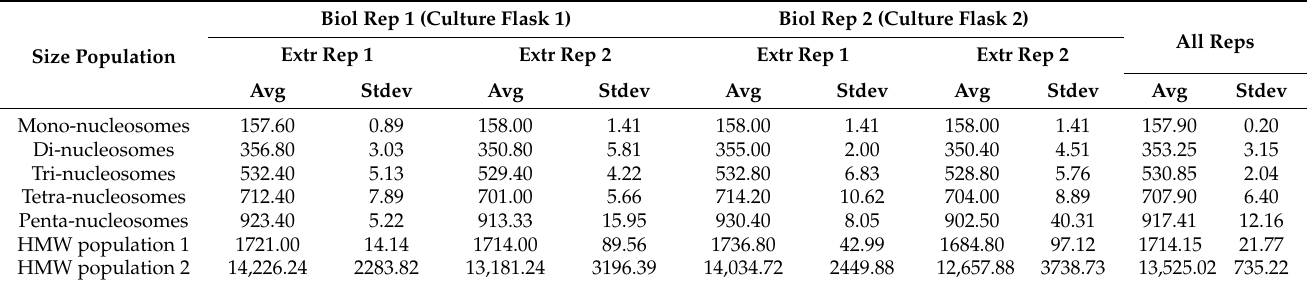
Table 2. The modal length (bp) of differently sized cell-free DNA (cfDNA) populations as determined by the FA dsDNA 930